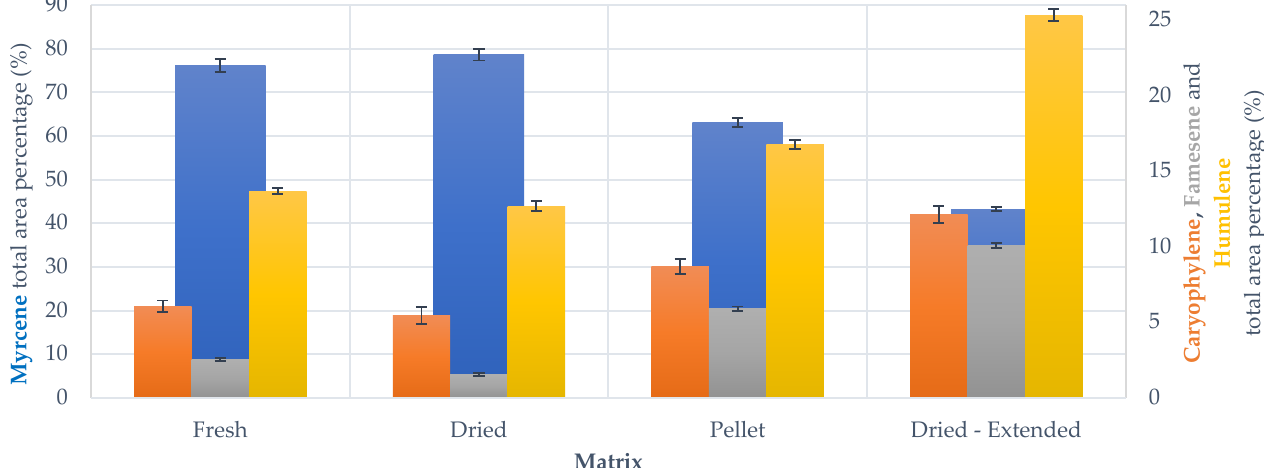
Figure 10. Main terpenoid distribution across ETHOS XL-MAHD (full load, FL), GC-MS analysis. Results reported as average ± SD.